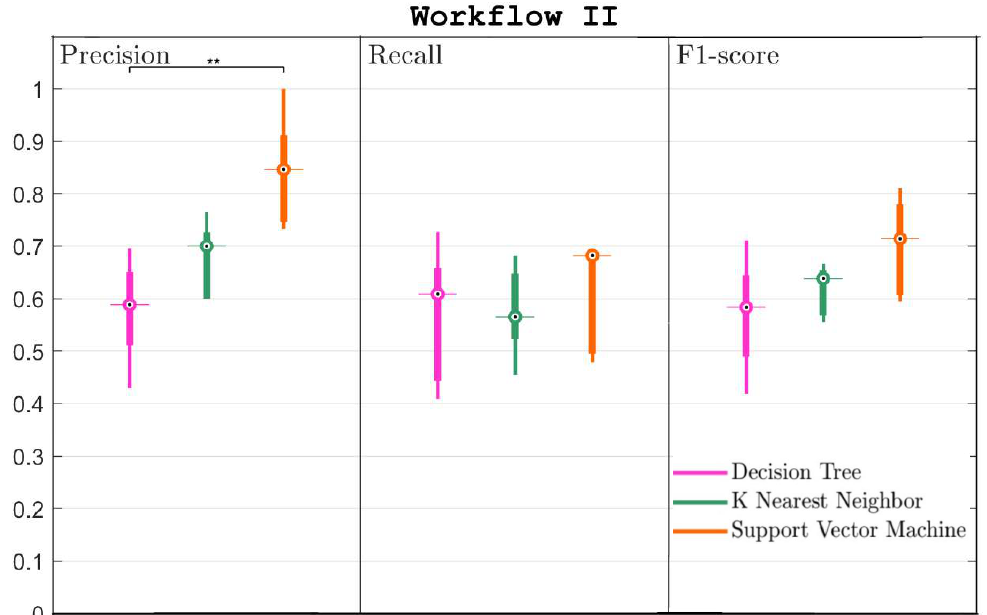
Figure 4. Workflow I. The boxplot of the precision, recall, and f1 score distributions on the test sets for the weld defective class among six classifiers conceived for workflow I with * representing statistically significant comparisons with p ≤ 0.05 and ** representing p ≤ 0.01.